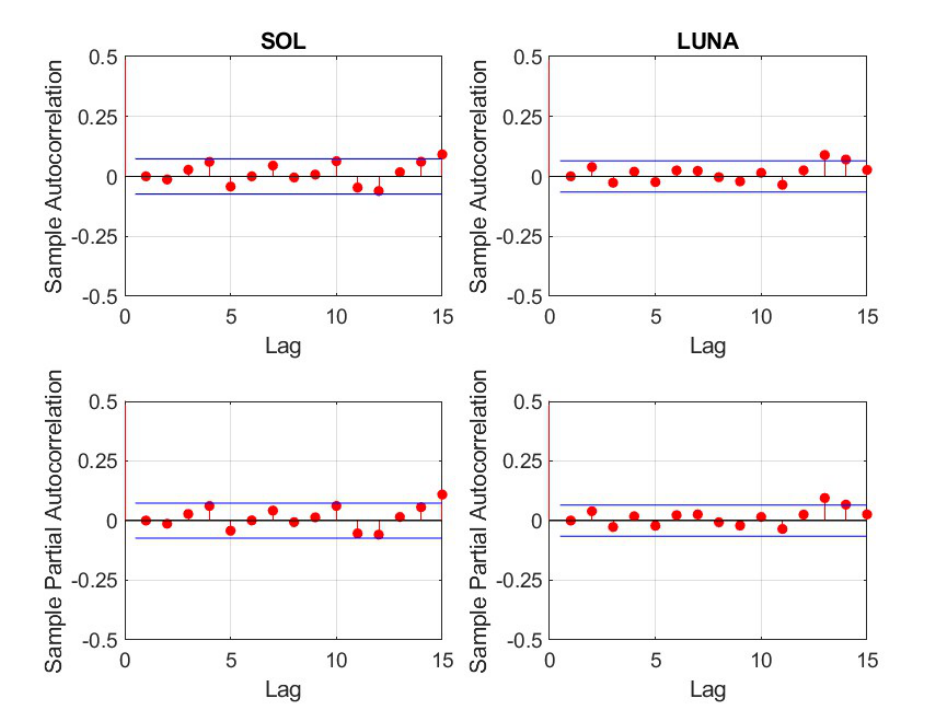
Figure A10. SOL’s and LUNA’s residuals’ autocorrelation.